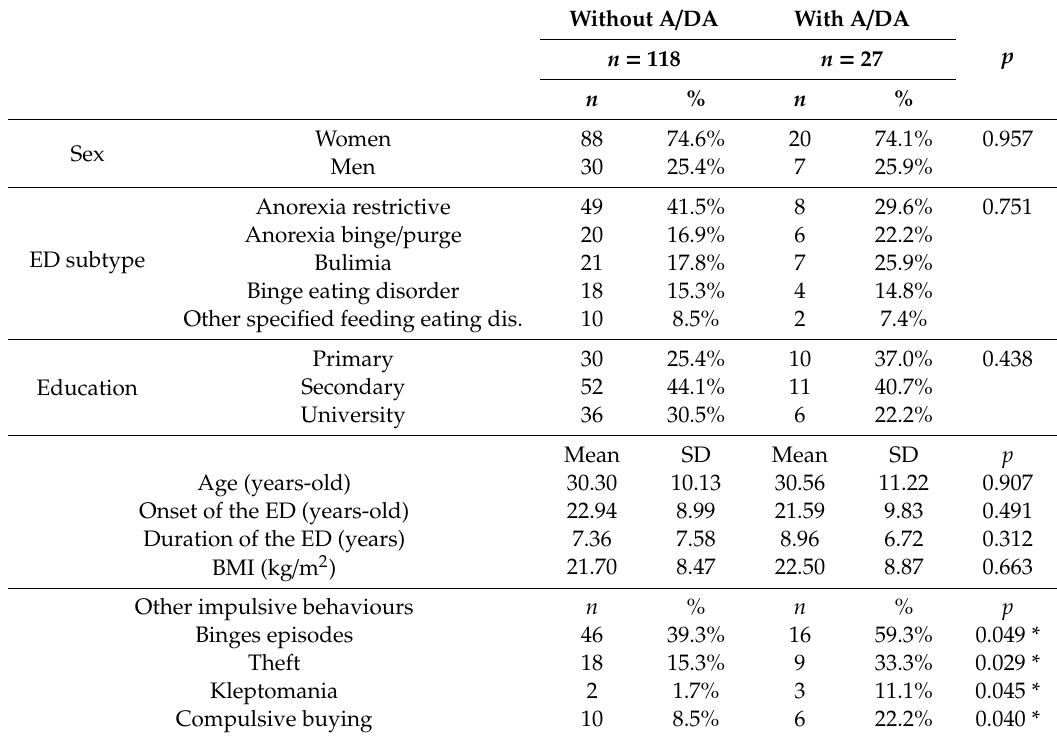
Table 1. Descriptive of the